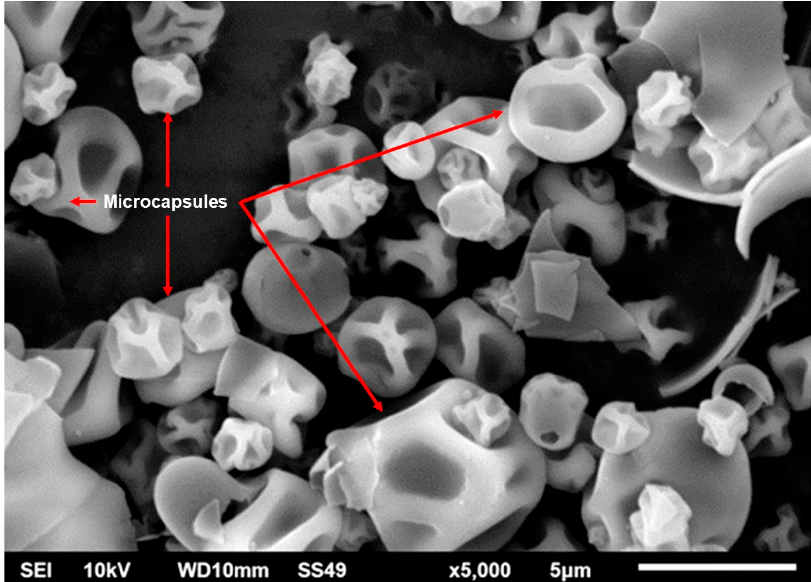
Figure 2. Scanning electron microscope image of the microcapsules. The image was viewed at ×5000, acceleration voltage of 10 kV, working distance of 10 mm, and scale of 5 μ m.